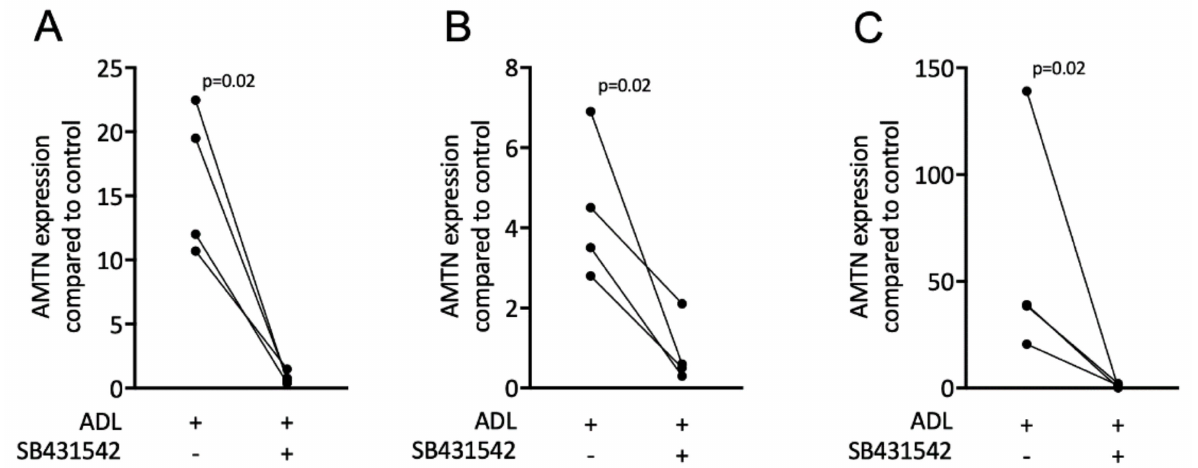
Figure 2. Acid dentin lysates induced-expression of AMTN is TGF- β receptor type 1 kinase-dependent. RT-PCR analysis of ( A ) HSC2, ( B ) TR146, and ( C ) GF exposed to ADL with and without SB431542 showed an increase in T β RI-dependent expression of AMTN. Statistics based on two-tailed Mann–Whitney test.